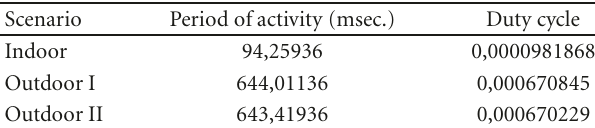
Table 3: Worst-case duty cycle. Scenario Period of activity